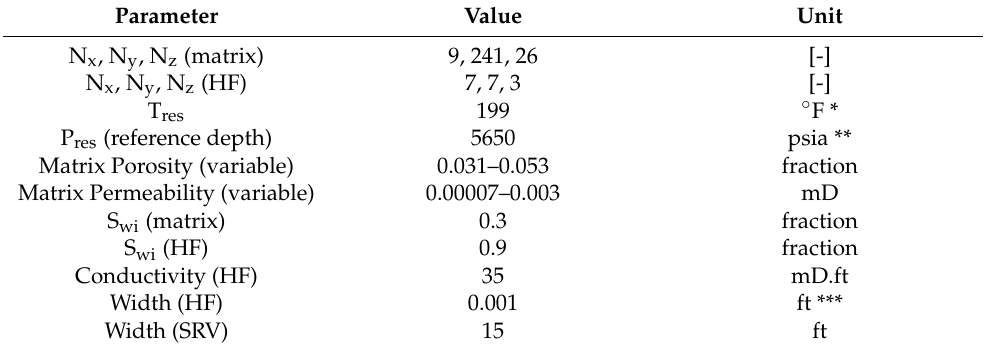
Table 1. Various model input values.